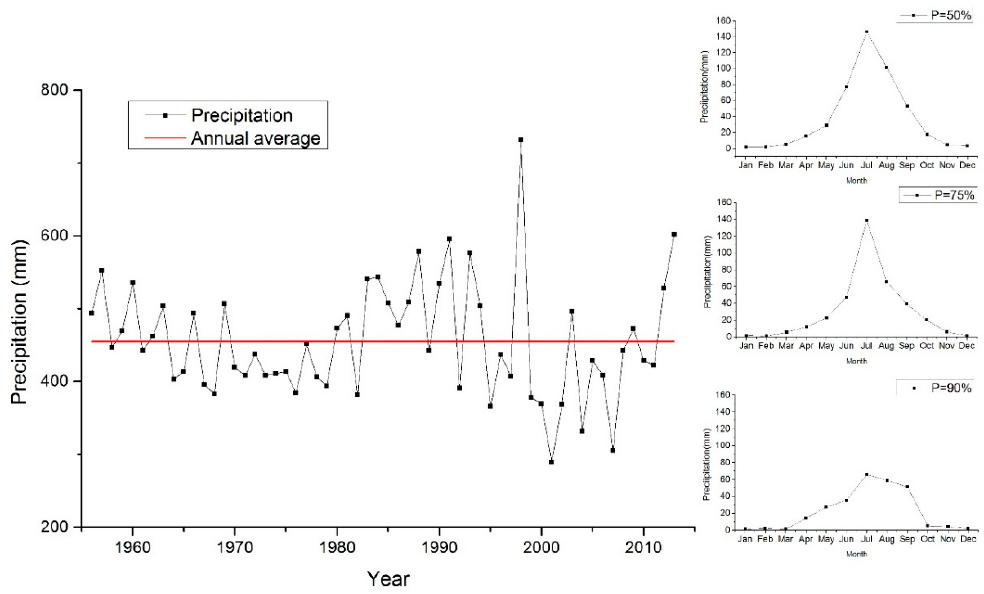
Figure 3. The average annual and monthly precipitation in the Nen River basin.